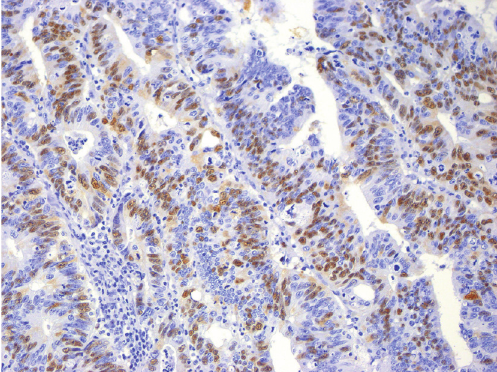
Figure 2: Representative example of immunopositivity grade 3 for cyclin D1 (original magnification × 200).